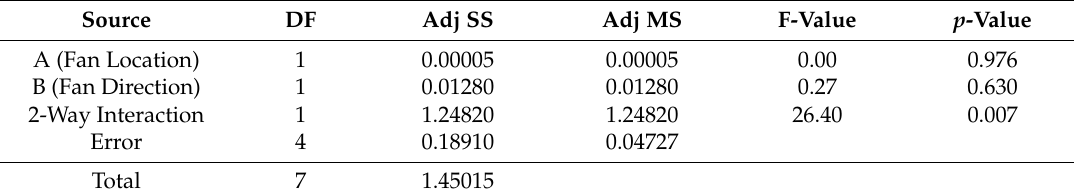
Table 3. Summary of analysis of variance (ANOVA) results.